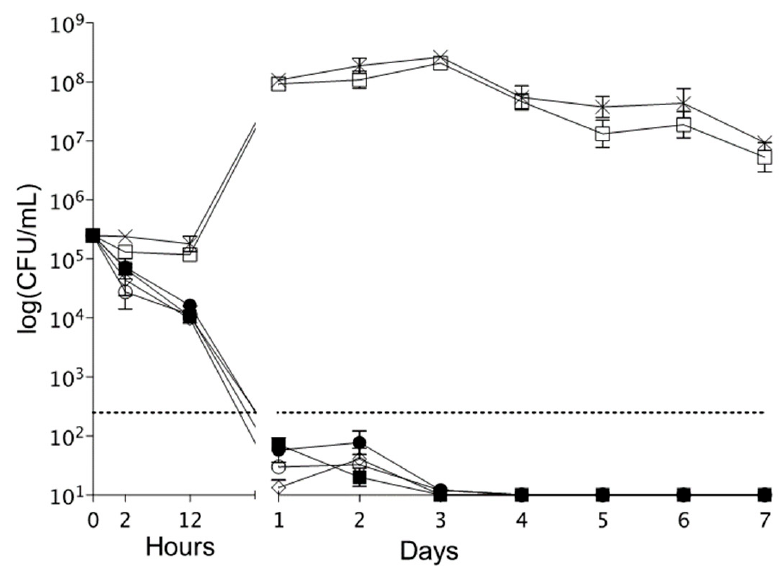
Figure 13. Bactericidal effect of the antibacterial and antiseptic drugs filled